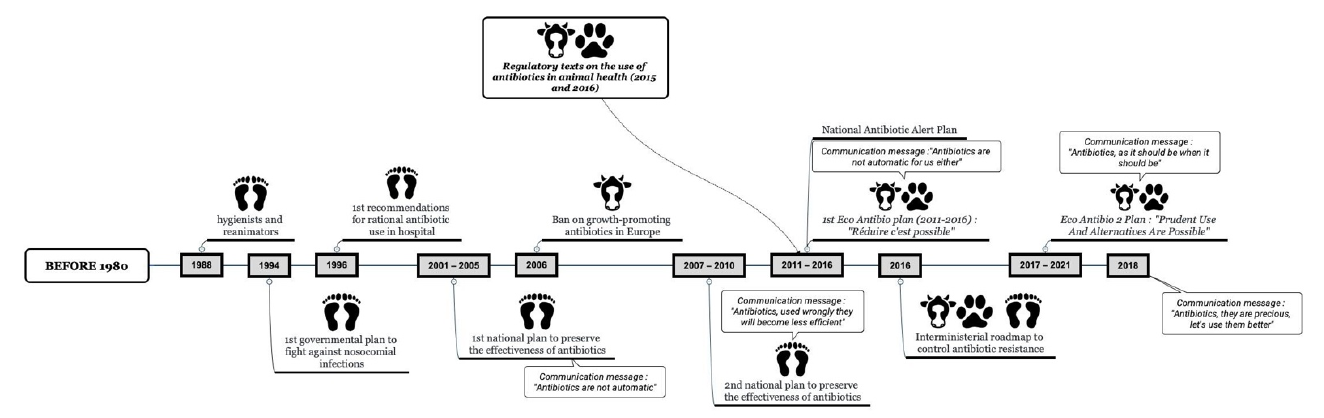
Figure 1. Chronology of the different action plans in human and animal health with communication announcement (footprints: human health; paws and bovine faces: animal health).